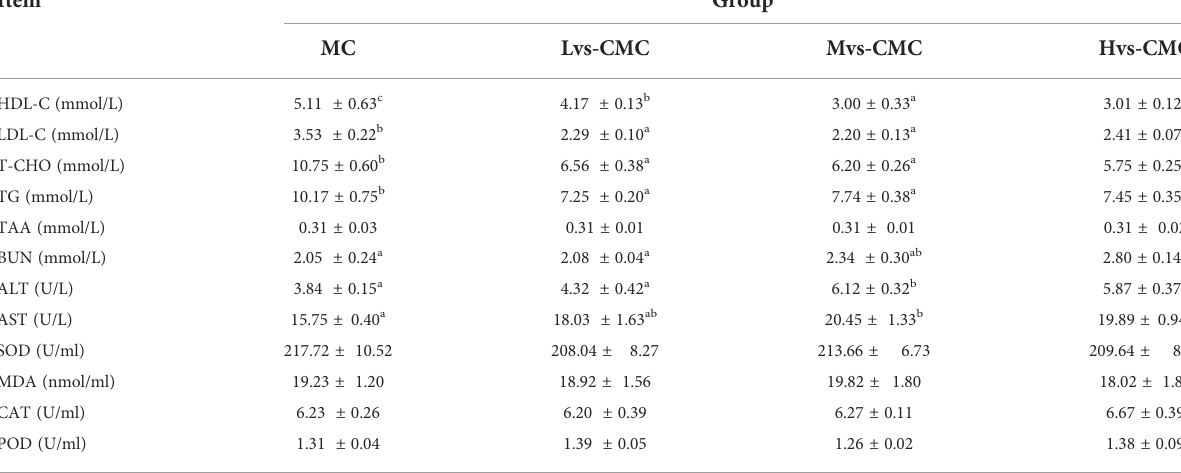
TABLE 6 Effects of increasing dietary viscosity on the serum biochemical indices of juvenile largemouth bass. Item